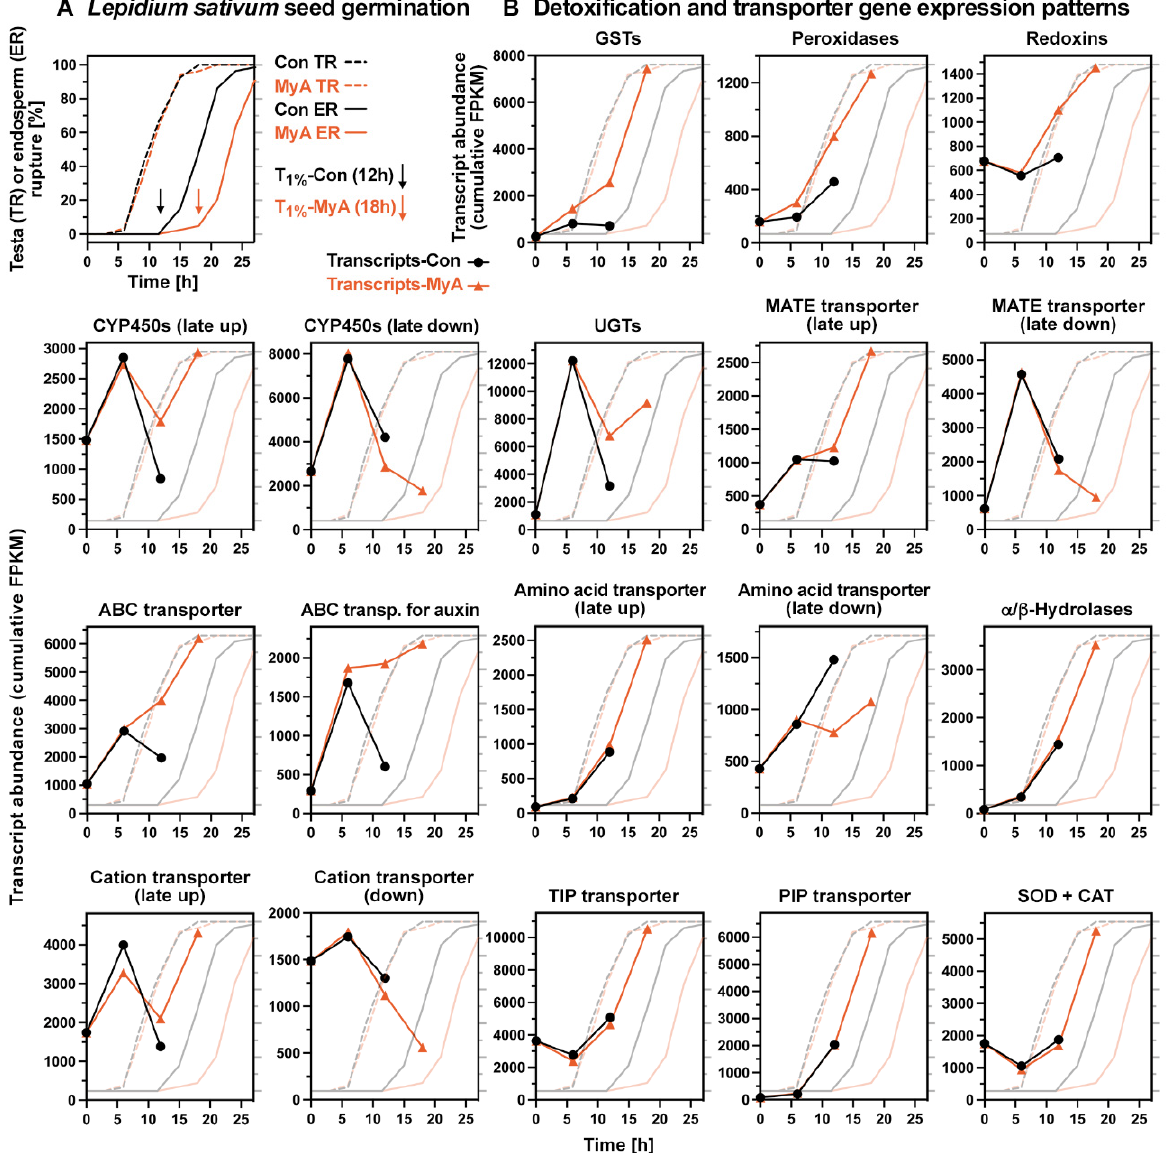
Figure 4. Phased induction of the seed’s detoxification programme by the phytotoxin MyA. ( A ) The kinetics of Lepidium sativum testa rupture (TR) and subsequent endosperm rupture (ER) without (Con) or with 0.5 mM MyA added. ( B ) Cumulative transcript expression patterns of detoxification and transporter gene groups regulated by MyA during L. sativum seed germination. Note that the cumulative FPKM values of differentially expressed transcript contigs (Data S2) are presented. For examples of MyA effects on specific genes (see Figures 2–6 and S6–S17).